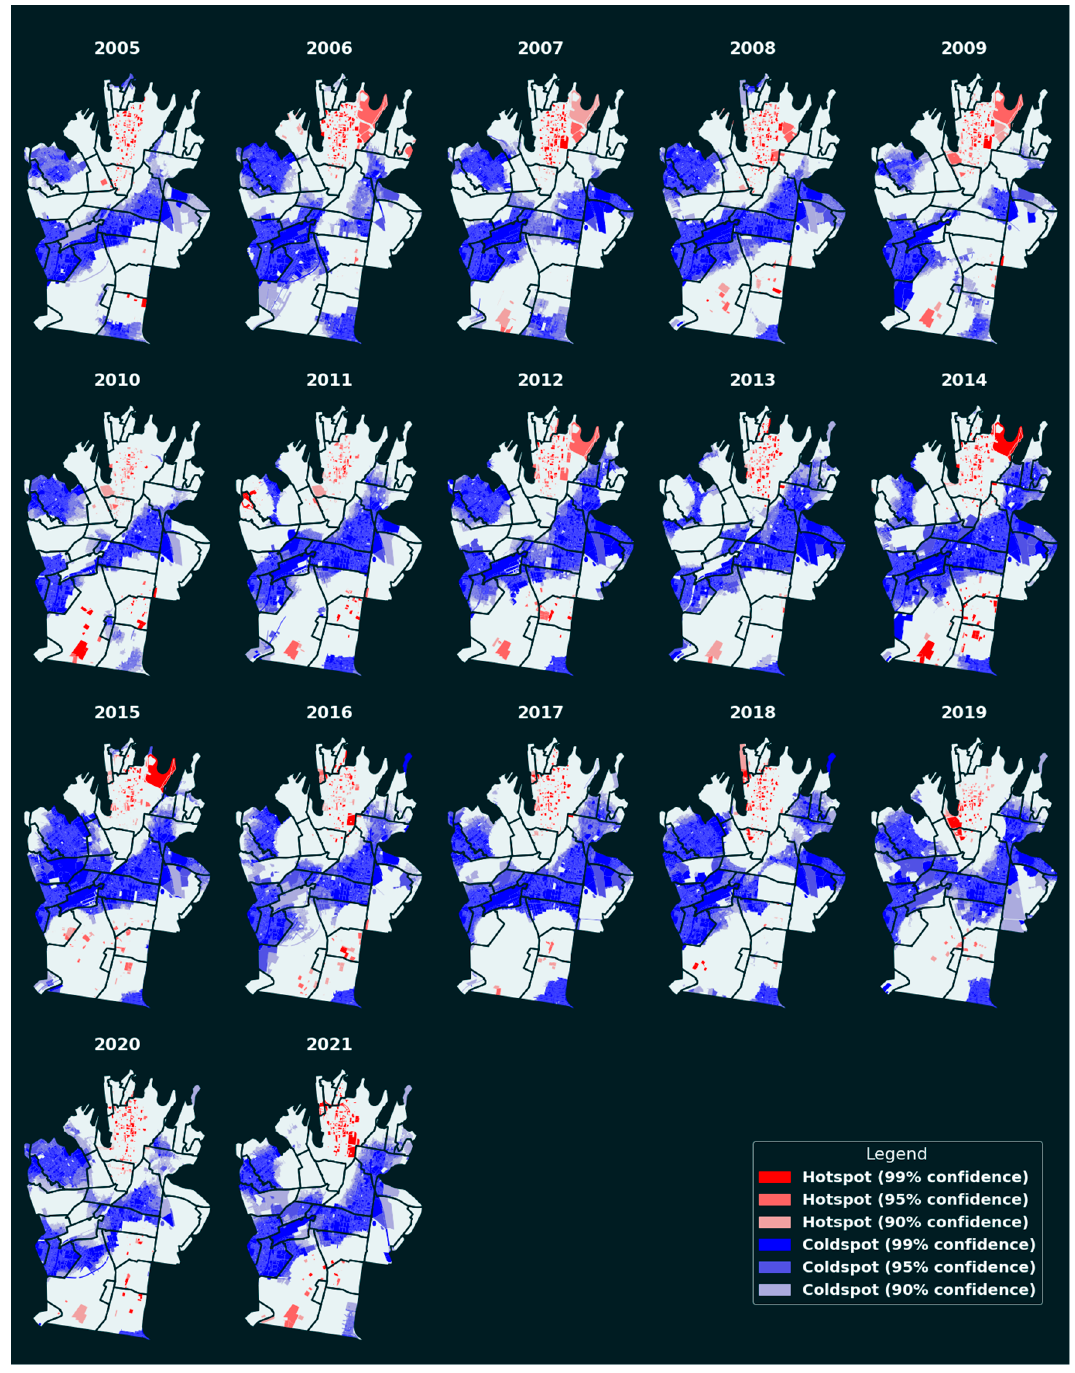
Figure 28. Estimated cost hot and cold spots by year (2005–2021). The uneven distribution of development spendings between suburbs is more closely examined in Figure 29. The Sydney CBD area has undoubtedly seen the largest amount of DA investments across the study period. In some years, such as 2006, 2007, 2017 and 2018, its total estimated cost is over 50% of that of the whole LGA. Zetland is near the top from 2005 onwards, but gradually makes way for other suburbs such as Alexandria, falling to fourth place in 2020. Other suburbs such as Rosebery, Haymarket and Waterloo are mostly in the second tier, occasionally having a spike in